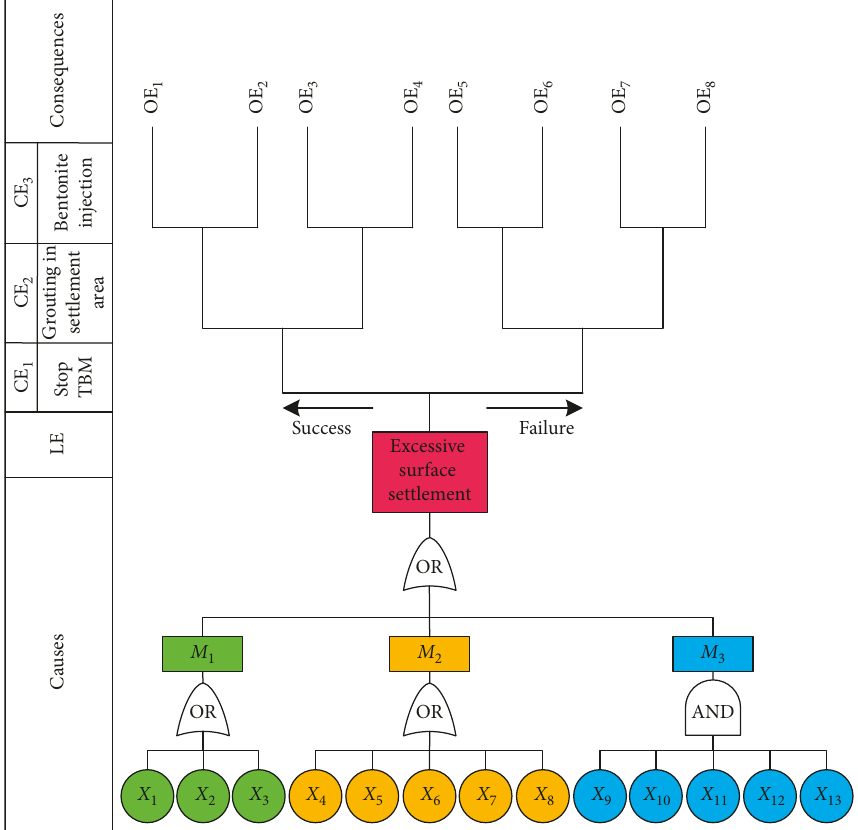
Figure 9: Diagram of bow-tie analysis for excessive surface